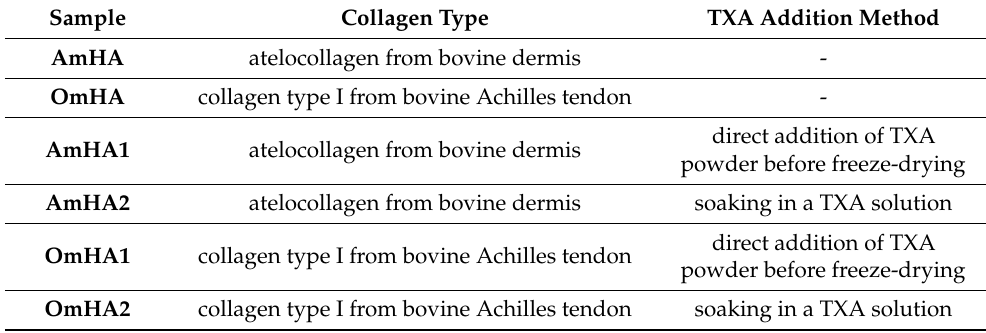
Table 1. Types of